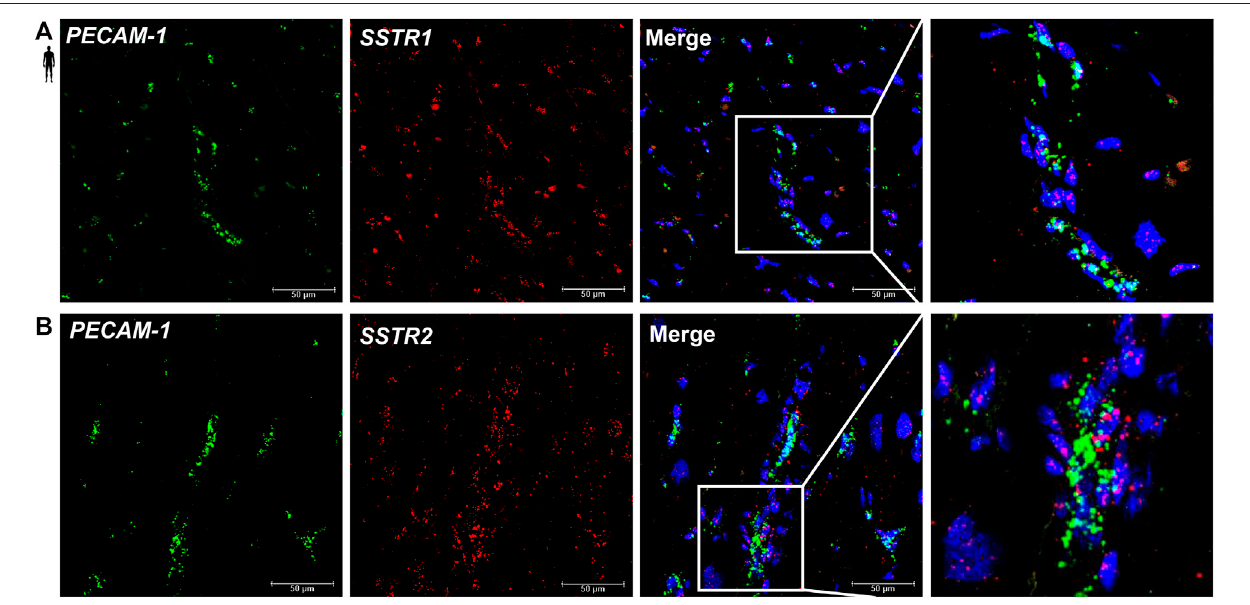
FIGURE 6 | Representative confocal microscopy images of RNA Scope ® - SSTR1 (A) and SSTR2 (B) mRNA expression in histological samples of human control left ventricle. Nuclei were stained with DAPI (blue). Fluorescein-labeled tyramide (green) was used to visualize mRNA of PECAM-1 (endothelial marker) and cyanine 3- (Cy3-) labeled tyramide (red) was used to visualize mRNA of SSTR1 or SSTR2 , respectively. Scale bar represents 50 µm.